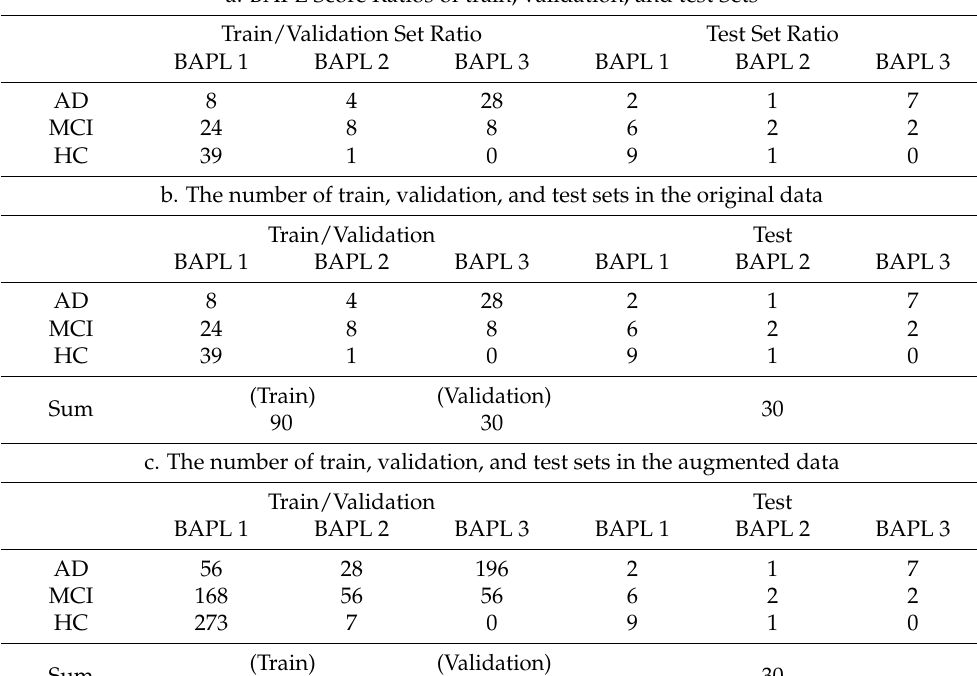
Table 2. Train, validation, and test sets. a. BAPL Score Ratios of train, validation, and test Sets